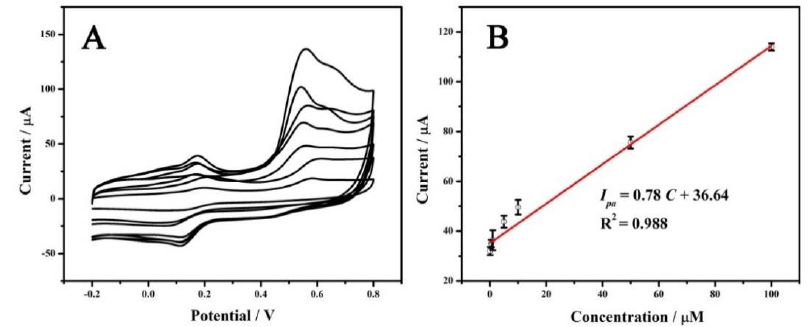
Figure 5. ( A ) CVs of MoSe 2 /rGO/GCE in 1 M PBS (pH 6.5) containing different concentrations of BPA (from the bottom to top: 0.1, 0.5, 1, 5, 10, 50, 100 μM); ( B ) the calibration line of the response I pa vs. C BPA .